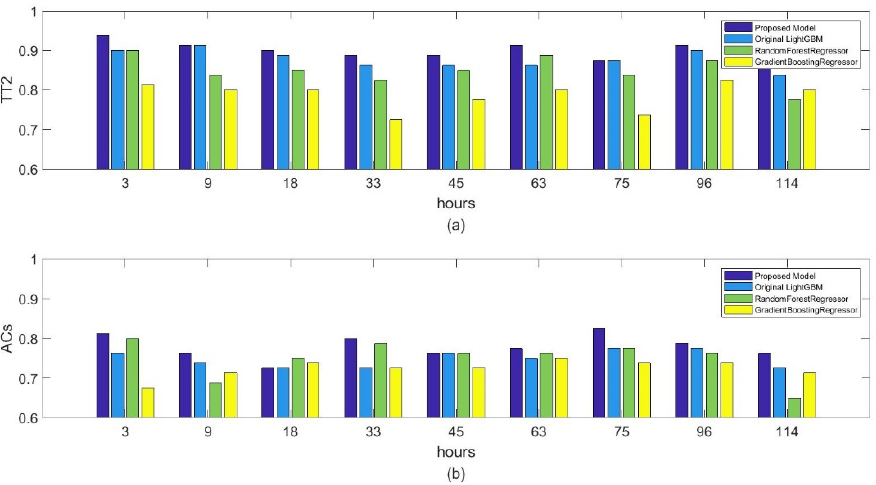
Figure 9. Comparison of various correction methods in the next 3, 9, 18, 33, 45, 63, 75, 96, and 114 h: ( a ) TT 2 index comparison; ( b ) AC s index comparison.